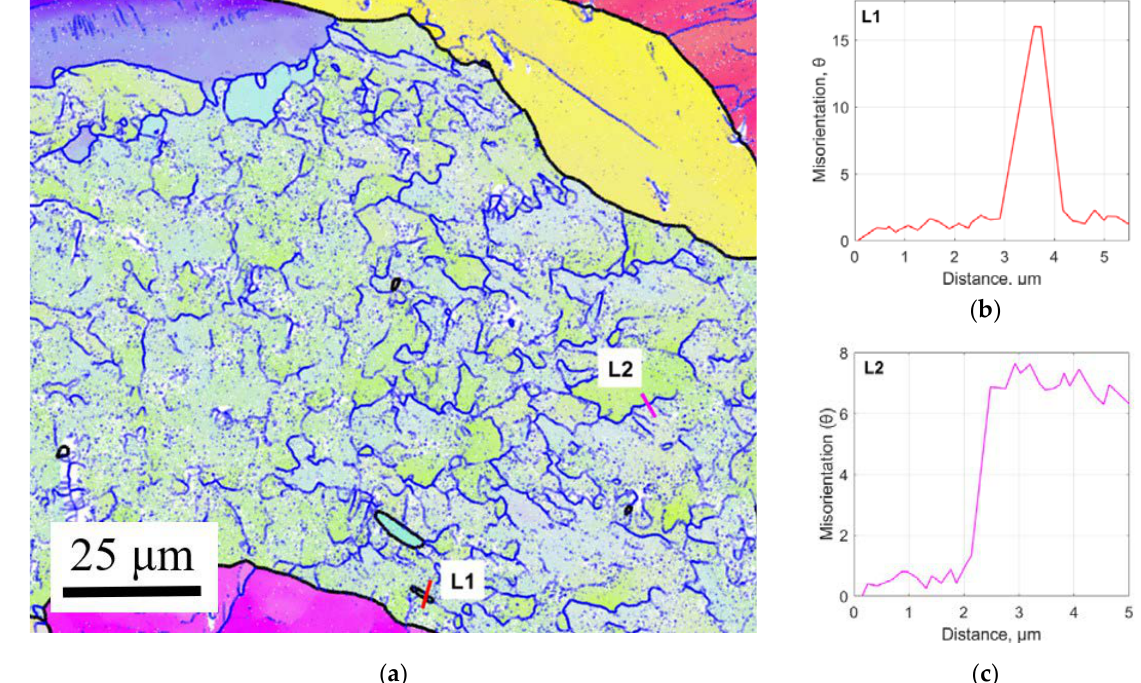
Figure 10. EBSD analysis of LMD tailored metal: ( a ) x2000 magnified coloured IPF map of 0.9 mm LMD layer; ( b ) misorientation across fully enclosed HAGB; ( c ) misorientation across segmented LAGB.